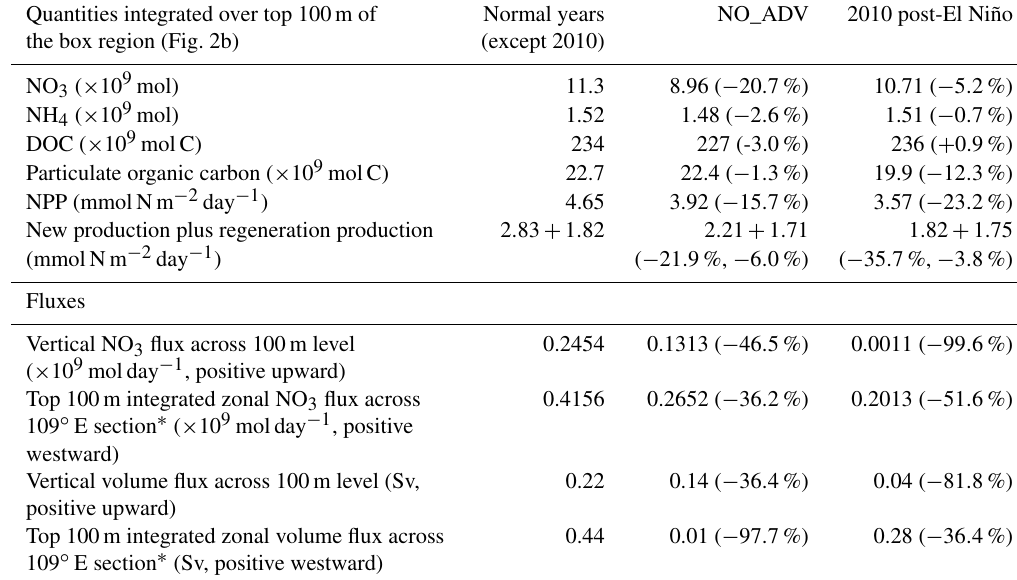
Table 1. Summery of the ecosystems in three model